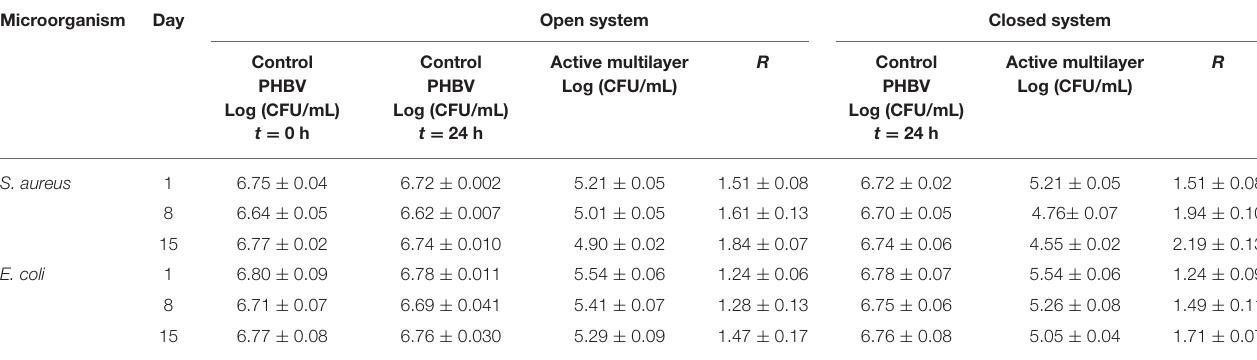
R Control R Control Control Active multilayer Active multilayer PHBV PHBV Log (CFU/mL) PHBV Log (CFU/mL) Log (CFU/mL) Log (CFU/mL) Log (CFU/mL) t = 0 h t = 24 h t = 24 h